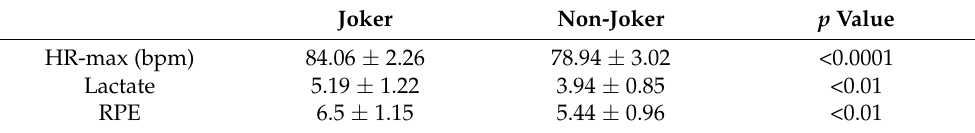
Table 2. Comparison of measures of exercise intensity between joker and non-joker OCs.